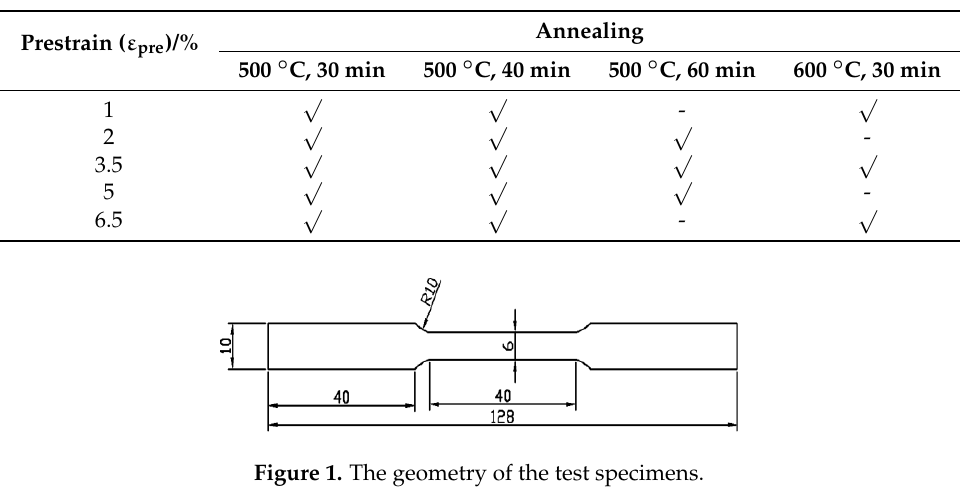
Table 2. Annealing experimental scheme.